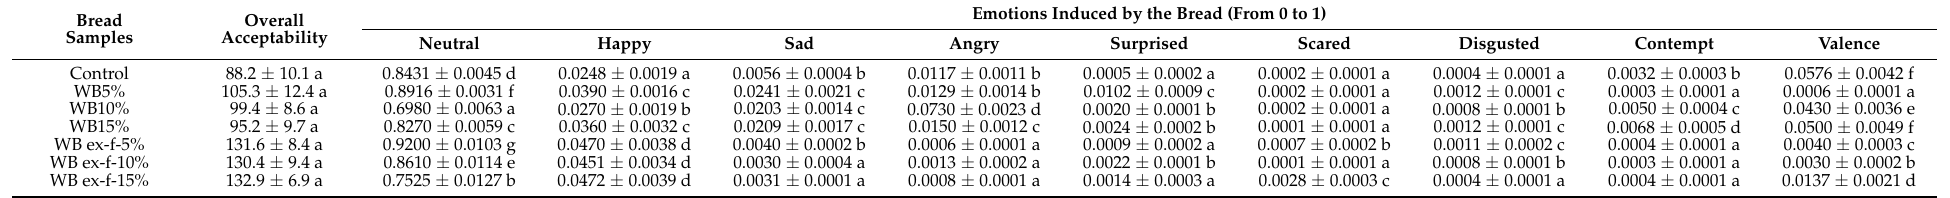
Table 3. Overall acceptability and emotions induced for consumers by breads enriched with untreated and extruded fermented wheat bran. Bread Samples Surprised Scared Disgusted Contempt